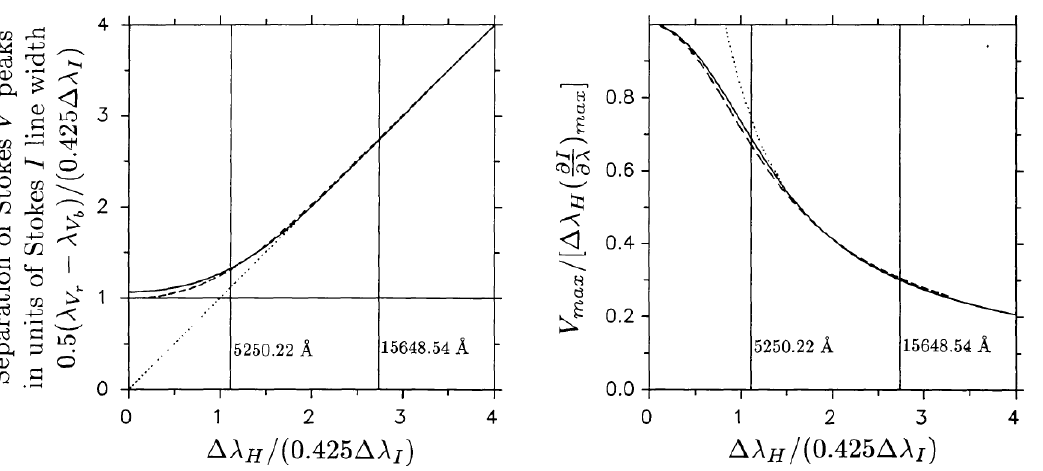
Figure 4: The benefit of making magnetic field Zeeman observations in the infrared is shown in this figure. On the left is a plot showing the separation of the Stokes V peaks for various Voigt profiles at a magnetic field of 1 kG for a visible line and an IR line. On the right is a plot showing the value of the Stokes V amplitude. The Zeeman splitting of the 1565 nm IR line is fully resolved at this magnetic field strength, and the weak field approximation does not need to be used to interpret the spectra. Image reproduced with permission from Stenflo et al. (1987), copyright by